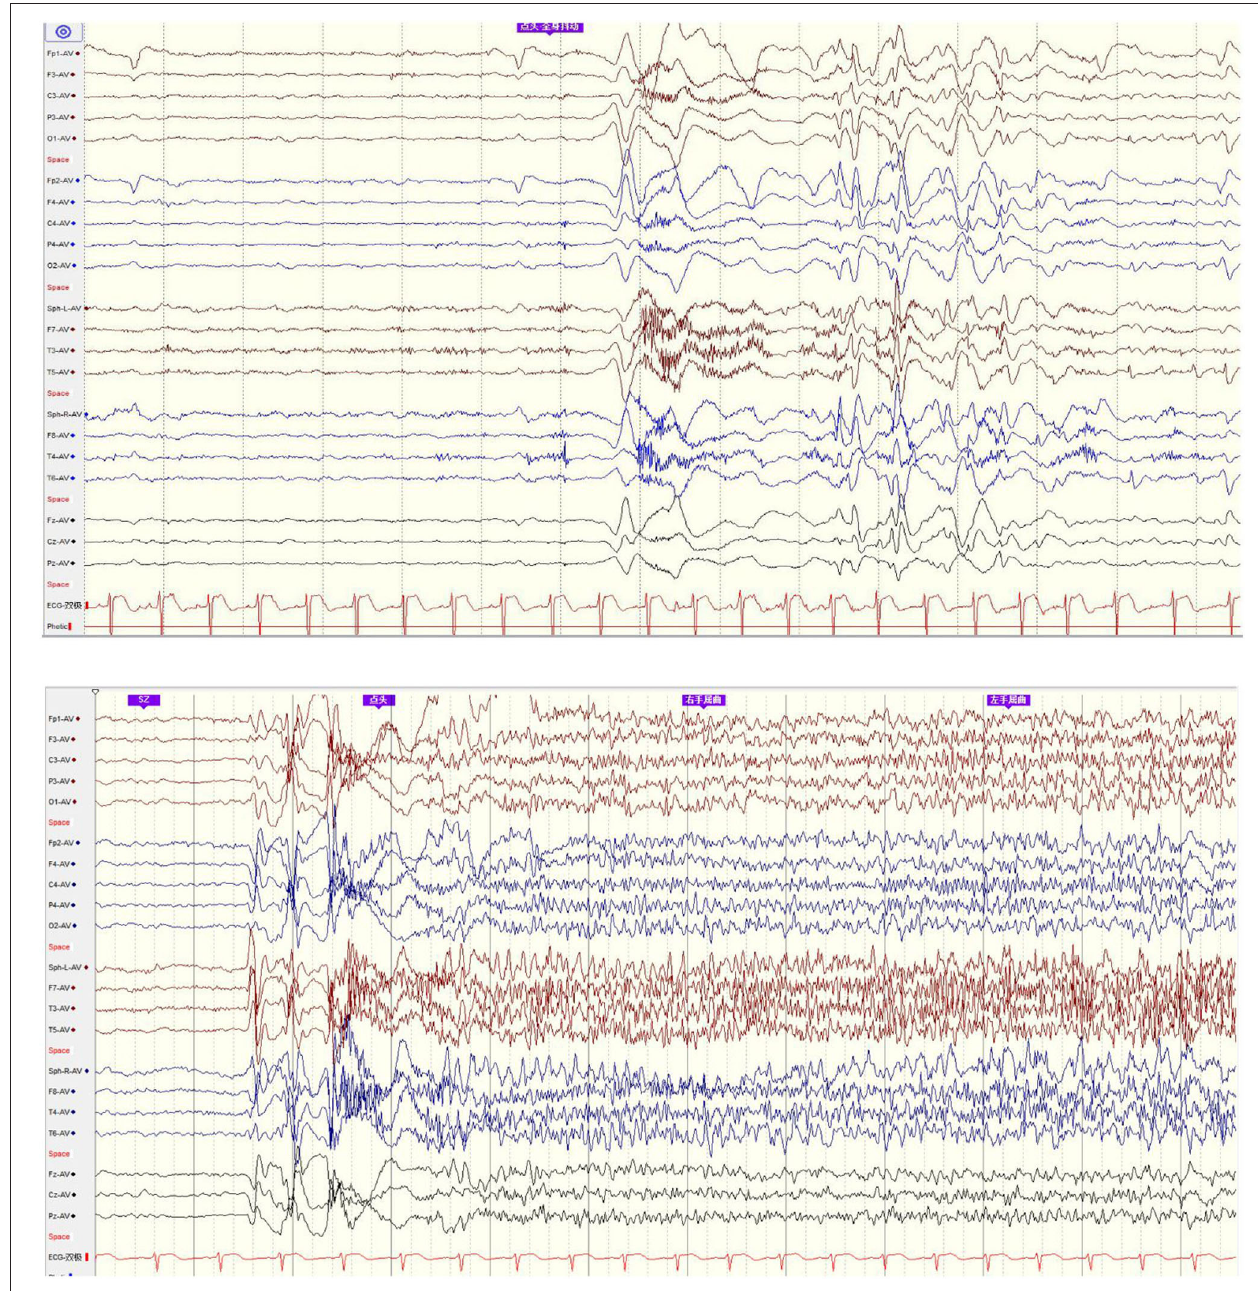
FIGURE 2 | EEG onset: epileptic spasm and tonic seizure involved general EEG onsets with little localization